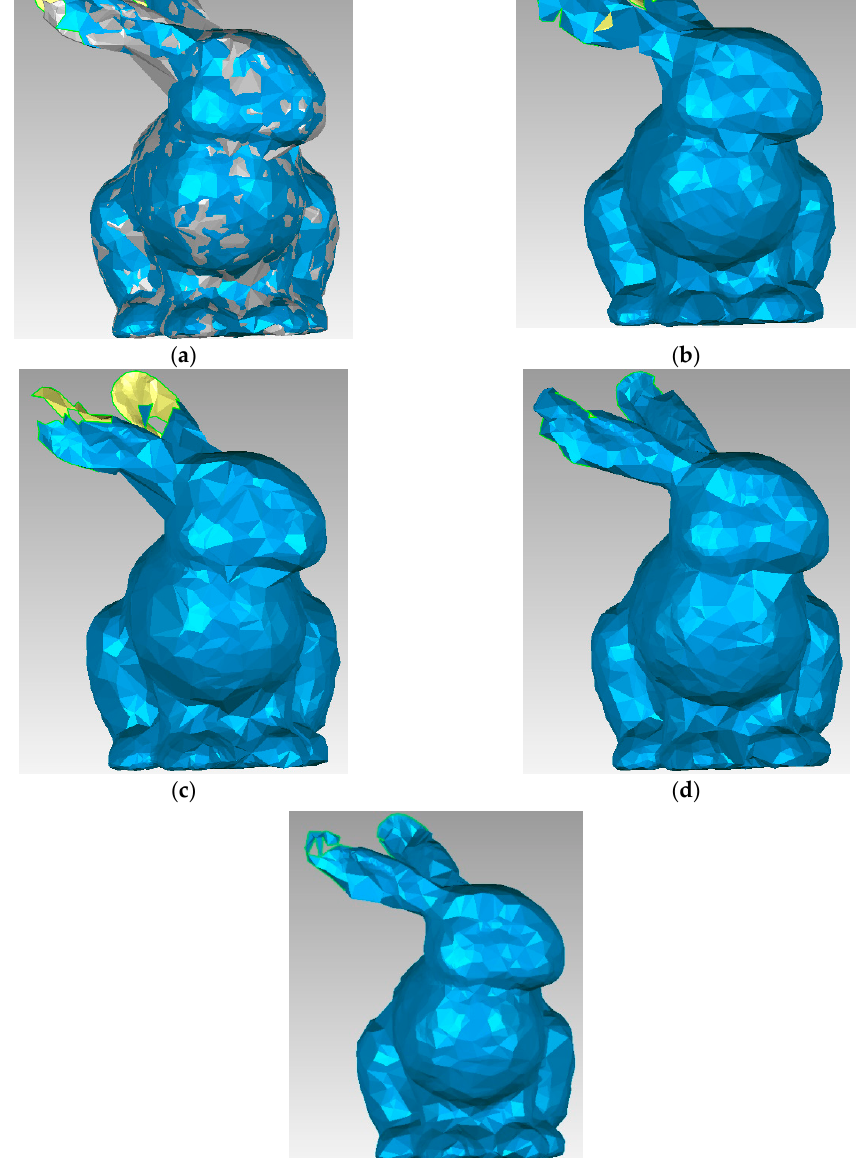
Figure 8. The simplification surface settings of the parameters where c = 10,000: ( a ) FPPS with k = 10 and σ = 1000; ( b ) FPPS with k = 25 and σ = 400; ( c ) FPPS with k = 50 and σ = 200; ( d ) FPPS with k = 80 and σ = 130; ( e ) FPPS with k = 100 and σ = 100. Table 3. The simplification surface